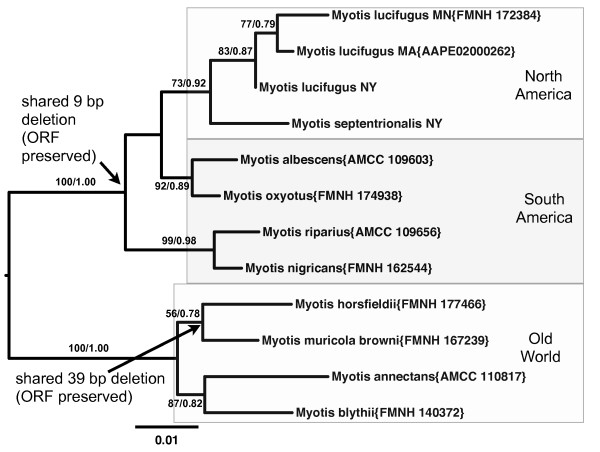
Midpoint rooted maximum likelihood phylogram of filovirus-like VP35 nucleotide sequences from vespertilionid bats. Three major geographic regions are shown by the shaded boxes. Support values (nonparametric bootstrap support/approximate likelihood ratio tests) are given above the branches. GenBank accession numbers or museum voucher numbers are provided in parentheses. See Additional file 8, Table S3 for details of specimen records and acronyms. Arrows show unique indels shared by sister taxa that preserve the open reading frame (i.e. all sequences appear to have an open reading frame in the genus Myotis). Note that the 9 bp deletion is not observed in the homologous sequence from the tarsier (supporting its derived position in New World Myotis sp.). The scale bar is based on substitutions per site.